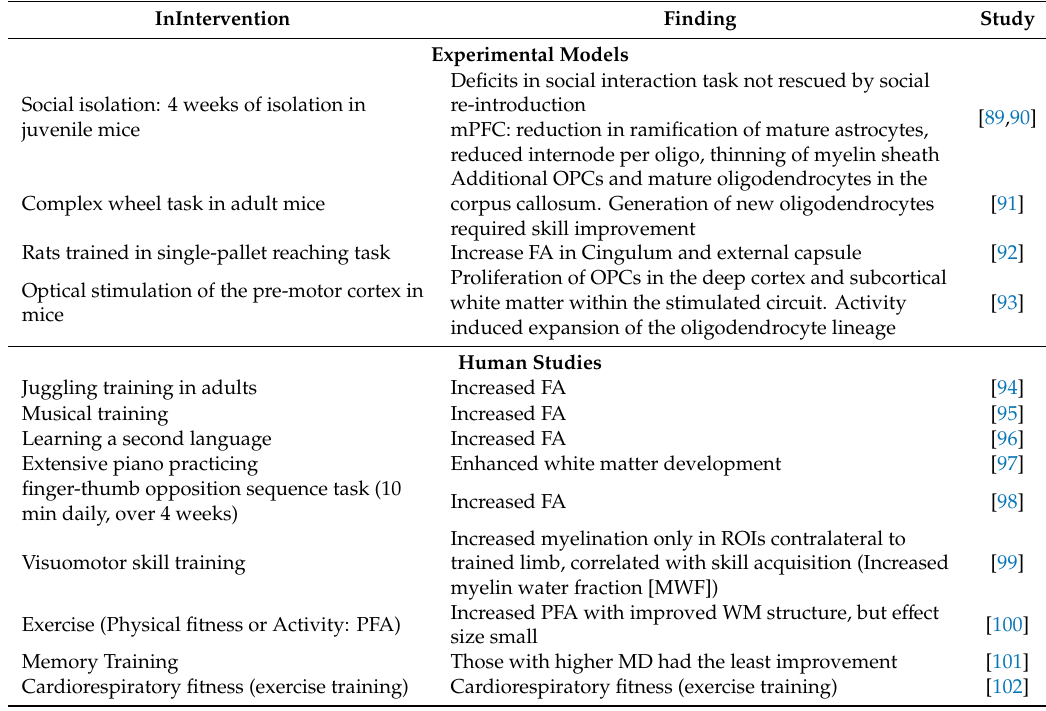
Table 1. Studies in Activity Dependent